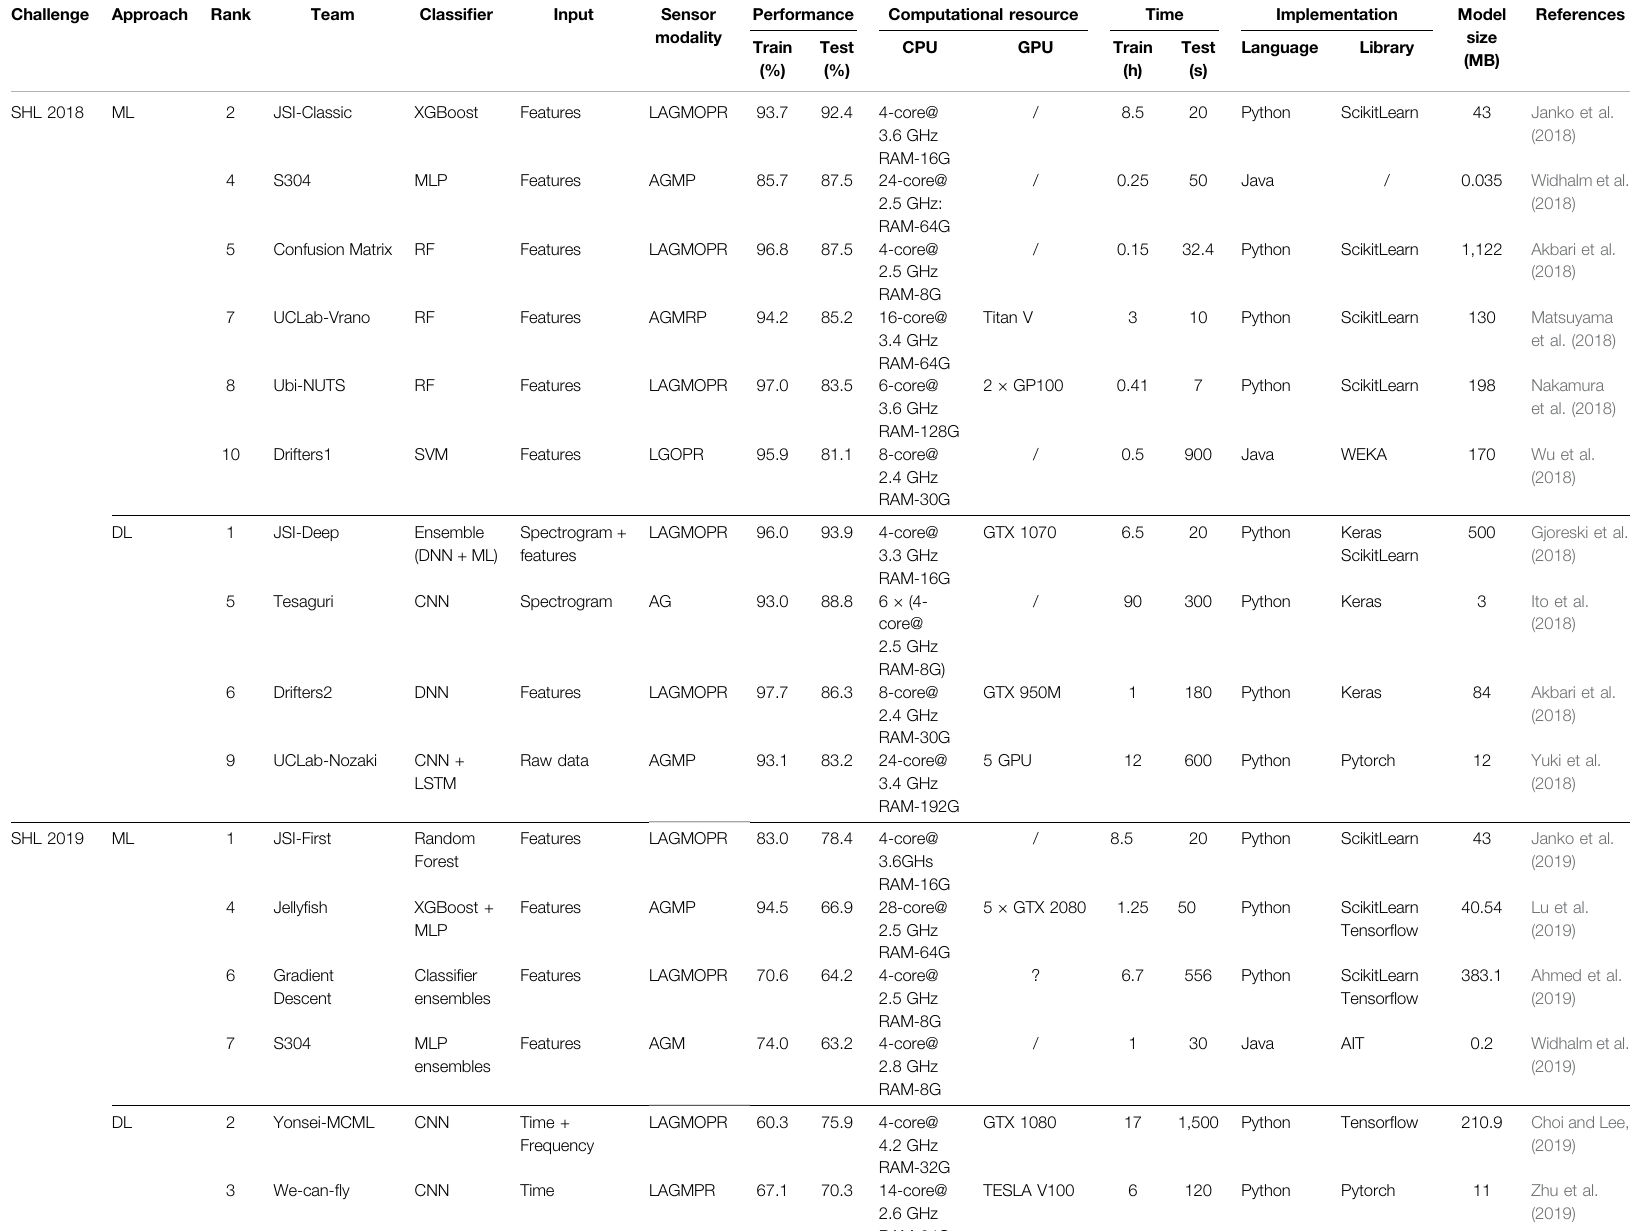
TABLE 4 | Summary of the top 10 submissions to SHL 2018 –